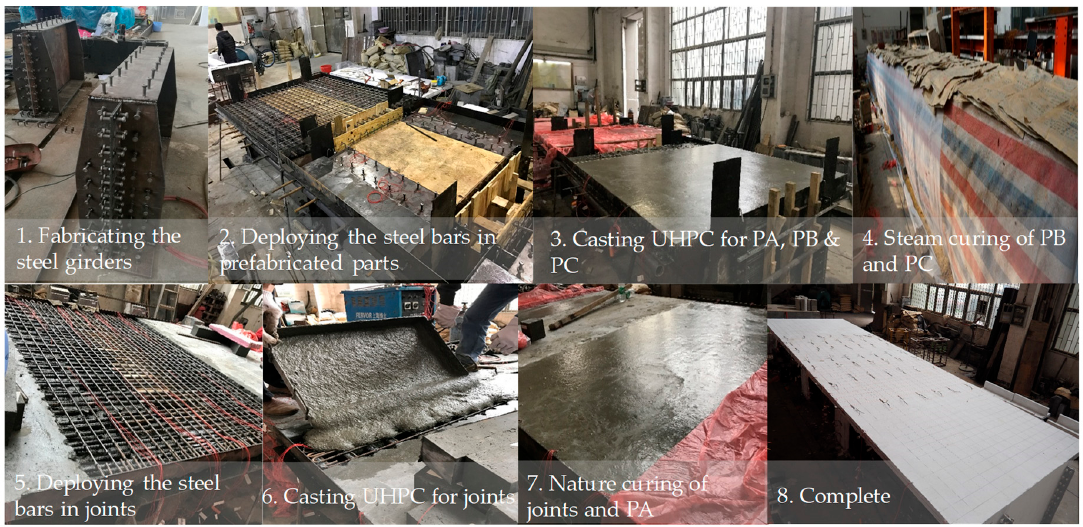
Figure 4. Specimen fabrication process. PA: part A, PB: part B, PC: part C.